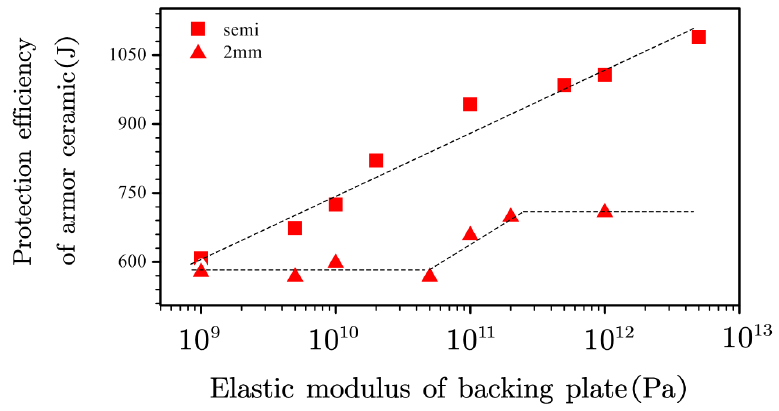
Figure 10. Effect of the elastic modulus of the backing plate on the protection efficiency of the armor Figure 10. ceramic.